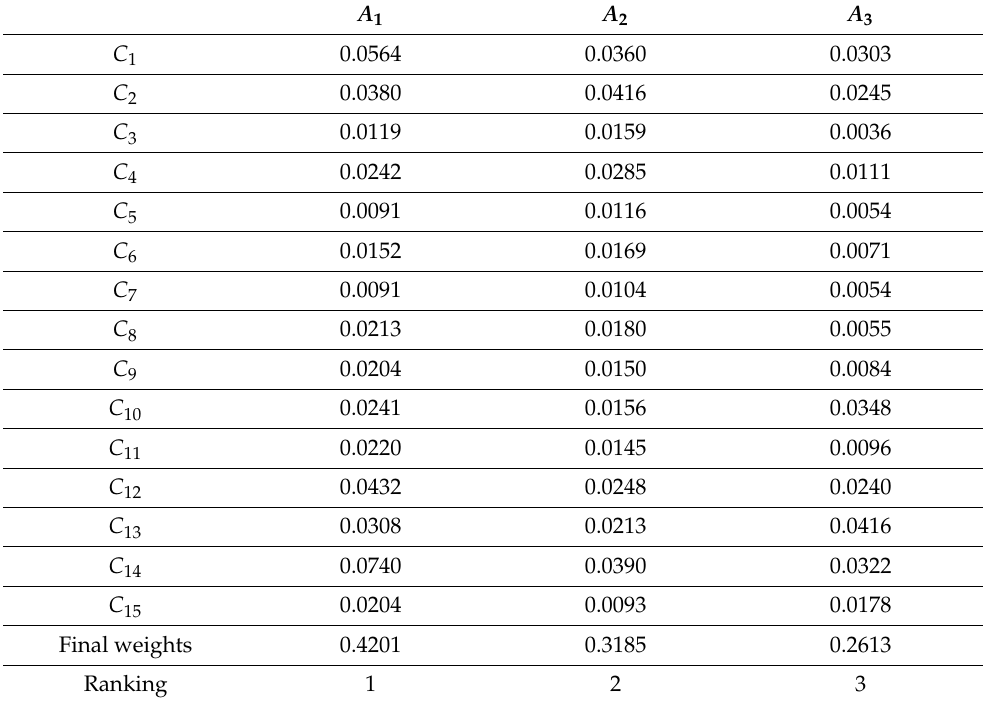
Table 9. The ranking results of AHP.